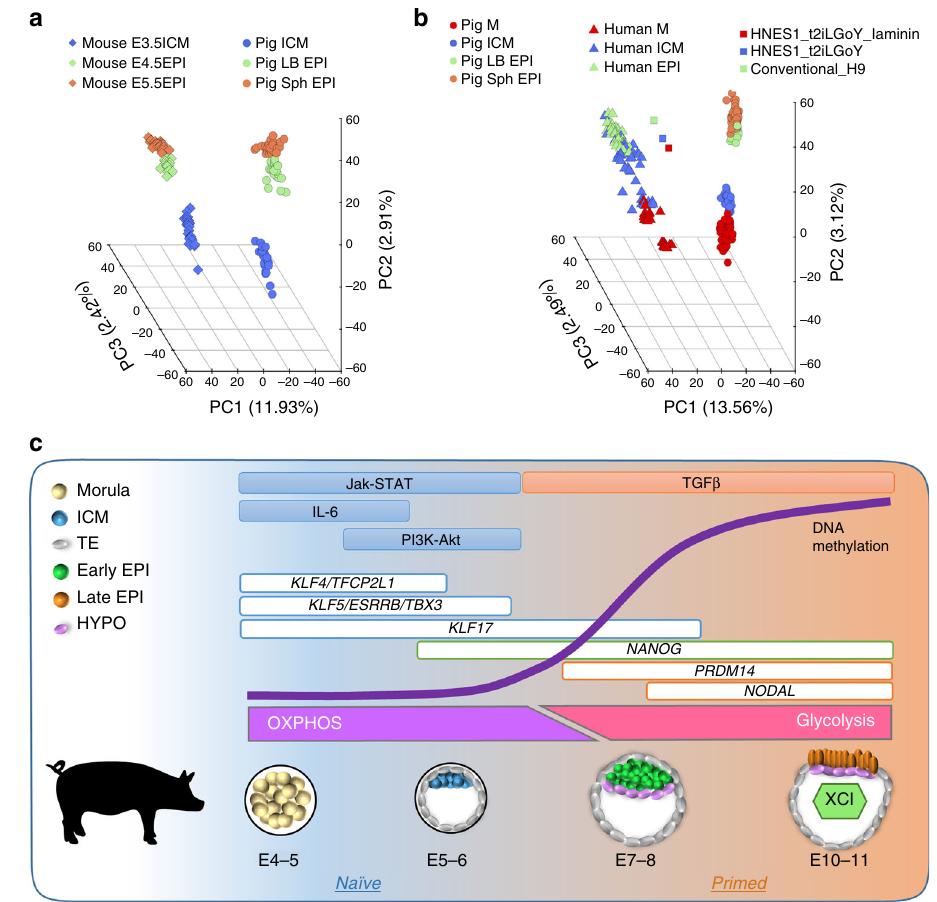
Fig. 9 Comparison of pig, mouse and human matched pluripotent states. a PCA of pig and mouse orthologous genes expressed in pluripotent cells. b PCA of pig and human orthologous genes expressed in embryonic cells and hESCs. c Summary of key events in the pluripotent compartment of the pig embryo. E: embryonic day, M: morula, EB: early blastocyst, LB: late blastocyst, Sph: spherical embryo, EPI: epiblast, HYPO: hypoblast, ICM: inner cell mass, TE: